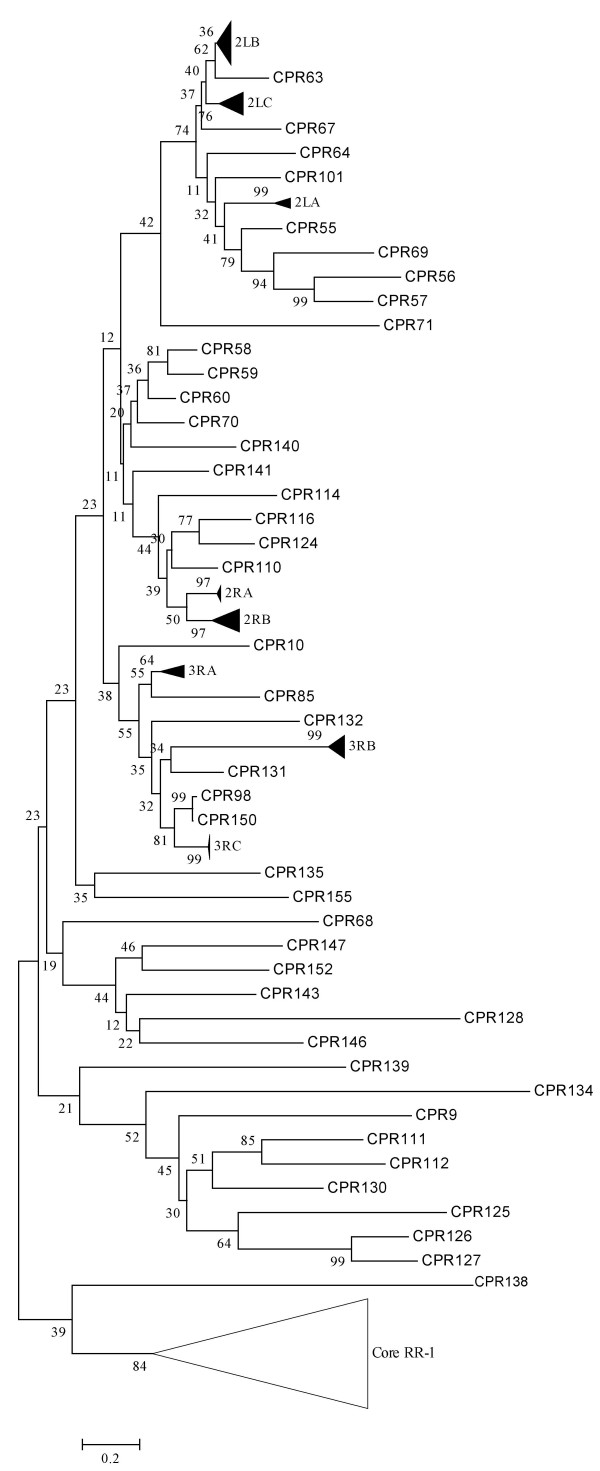
Phylogenetic relationships of the core RR-2 proteins. A detailed view of the neighbor-joining tree of An. gambiae CPR genes with the branch leading to the main group of RR-1 proteins shown in Figure 6 collapsed as are the individual sequence clusters. Numbers at nodes indicate the percentage of 1000 bootstrap replicates that support the node.